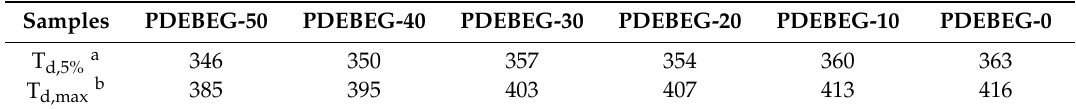
Figure 6. ( a ) TGA and ( b ) TGA derivative curves of PDEBEG. Table 4. Thermal properties of PDEBEG.